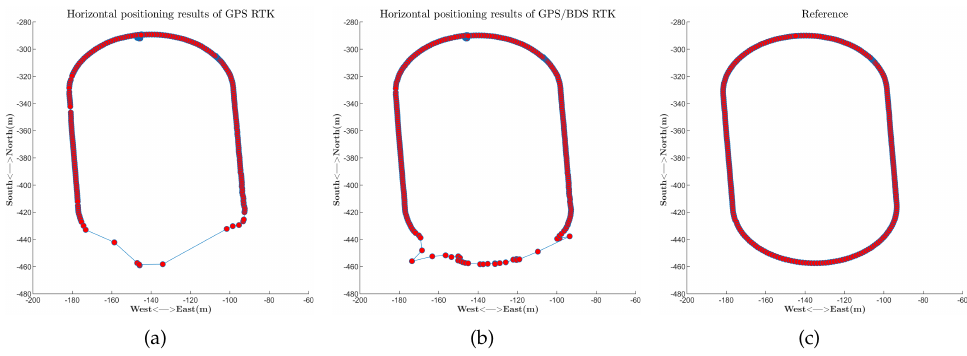
Figure 12. The performance comparison of GPS RTK, GPS/BDS RTK, and the reference. ( a ) Hor- izontal positioning results of GPS RTK. ( b ) Horizontal positioning results of GPS/BDS RTK. ( c ) The